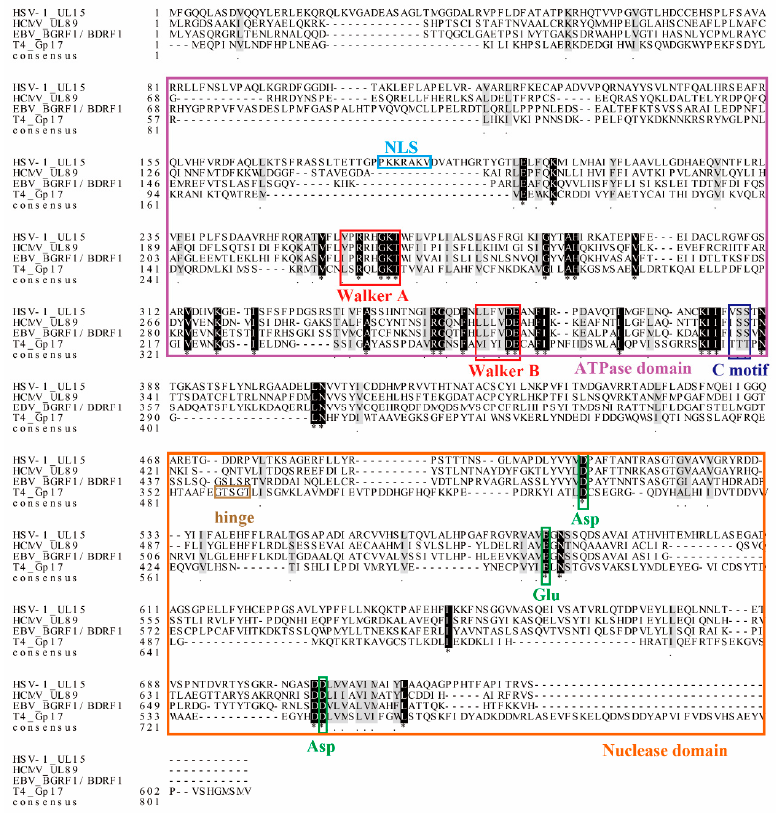
Figure 3. Sequence analysis and functional site comparison of pUL15 and homologs of different subfamilies. The alignment was completed by using MEGA7 and ClustalX2. The purple box represents the amino acid sequence of the N-terminal pUL15 and homologs ATPase activity domain; light blue box represents HSV-1 pUL15 nuclear localization signal (NLS); red box represents the Walker motif; dark blue box represents the C motif; orange box represents pUL15 C-terminal nuclease domain; brown box represents bacteriophage T4 Gp17 Hinge sequence; green box represents the catalytic triplet Asp-Glu-Asp motif. The * means that the amino acids at this site are identical. Table 2. Catalytic site of nuclease activity in pUL15 and homologs.